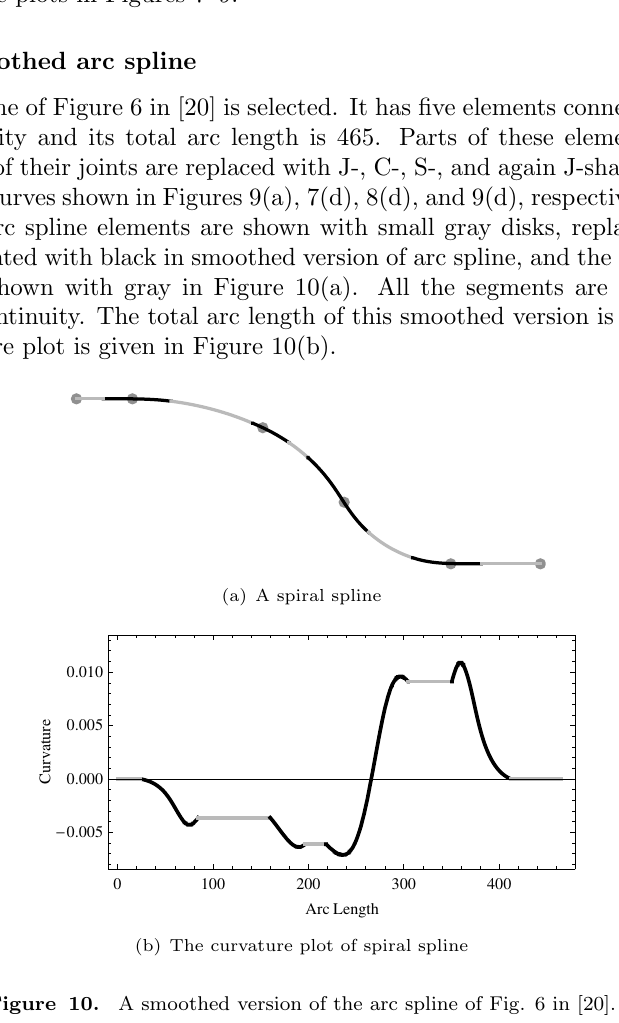
Figure 10. A smoothed version of the arc spline of Fig. 6 in